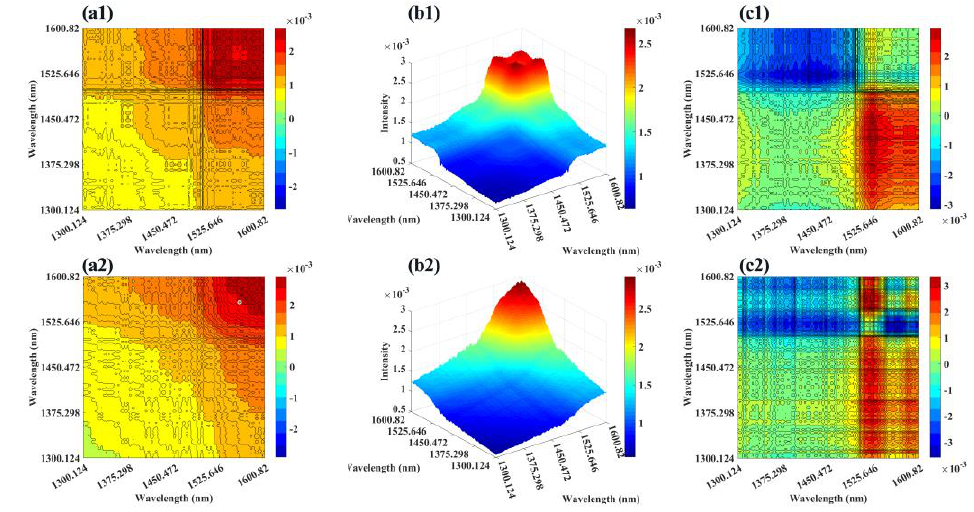
Figure 3. Synchronous spectra of ( a1 ) LMWHA – A and ( a2 ) LMWHA – E; Auto-peak spectra of ( b1 ) LMWHA – A and ( b2 ) LMWHA – E; Asynchronous spectra of ( c1 ) LMWHA – A and ( c2 ) LMWHA – E. ( b1 ) LMWHA–A and ( b2 ) LMWHA–E; Asynchronous spectra of ( c1 ) LMWHA–A and ( c2 )